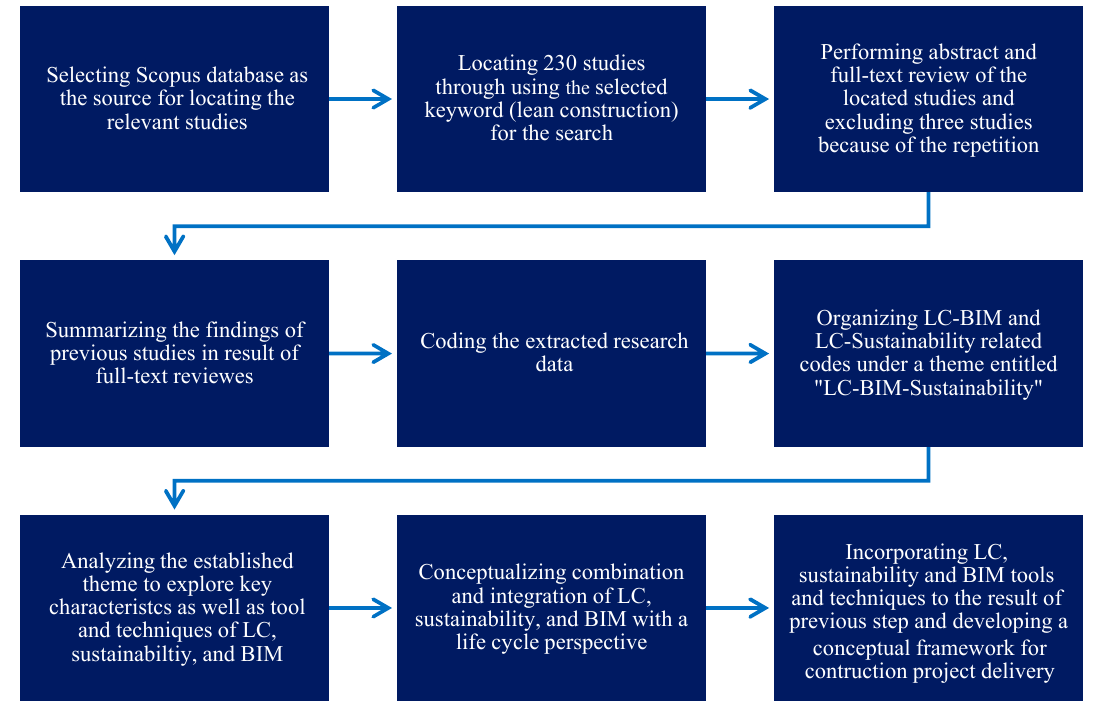
Figure 1. Research Figure 1. Research process.